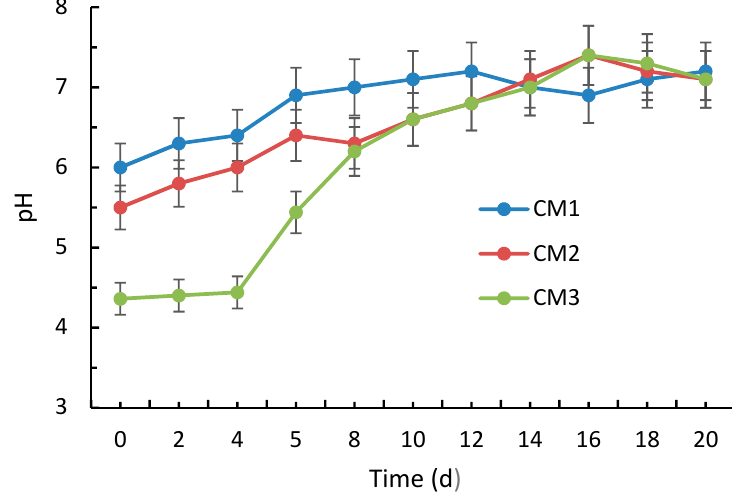
Figure 2. pH changes during biomass production in media with different concentrations of vinasse.